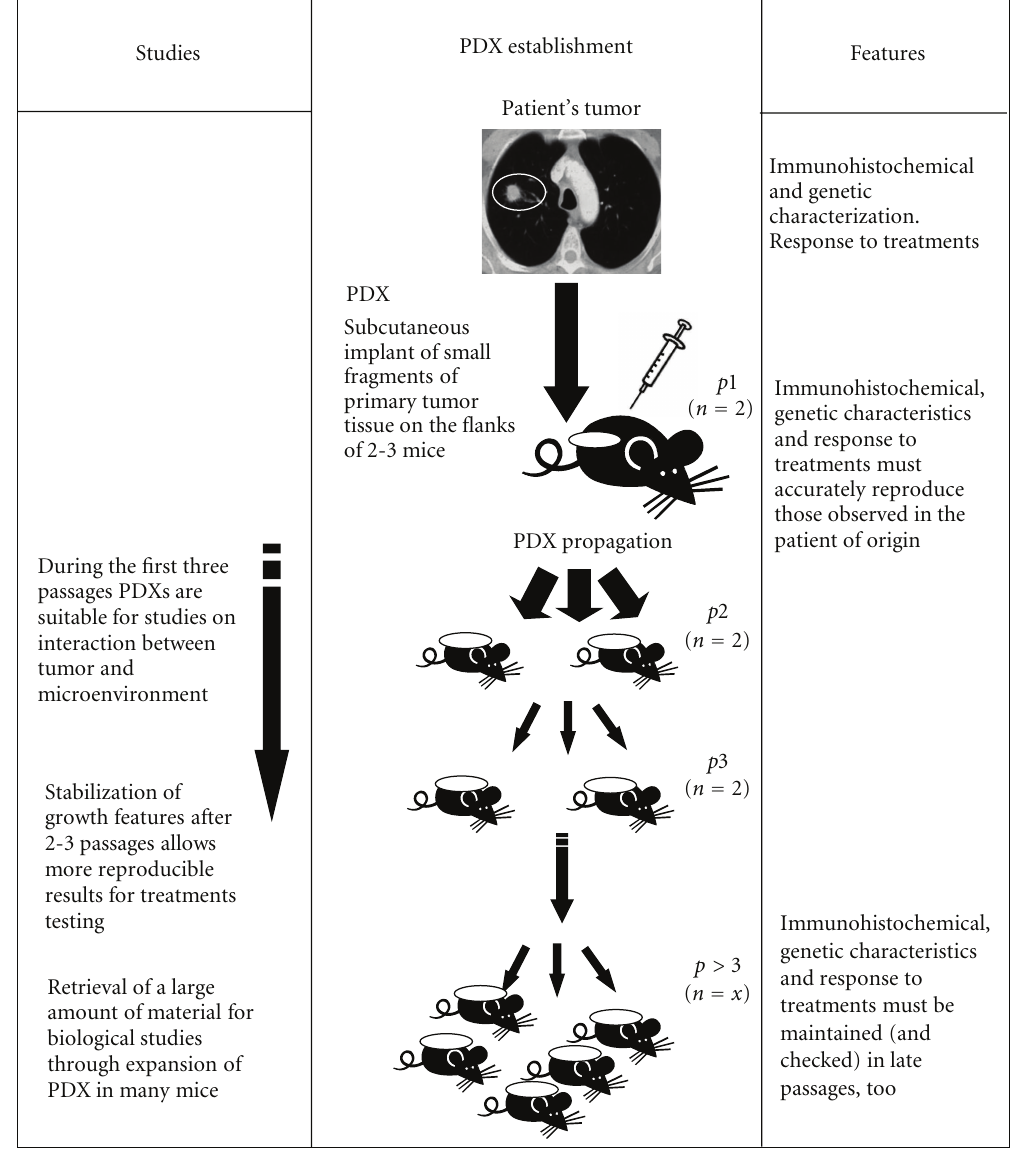
Figure 1: Flow-chart of establishment of patient-derived xenografts. Fragments of primary tumor samples are initially implanted subcutaneously in both flanks of 1-2 immunocompromised mice, depending on tissue availability ( p 0). When tumors reach the exponential growth phase they are removed from donor mice, reduced into fragments, and serially transplanted in new recipient mice ( p 1). For investigational purposes (i.e., drug treatments or subpopulation analysis) PDXs can be expanded in a higher number of mice in order to obtain statistical relevant results or su ffi cient biological material for analysis, respectively. ( p : sequential passage in immunocompromised mouse; n : number of